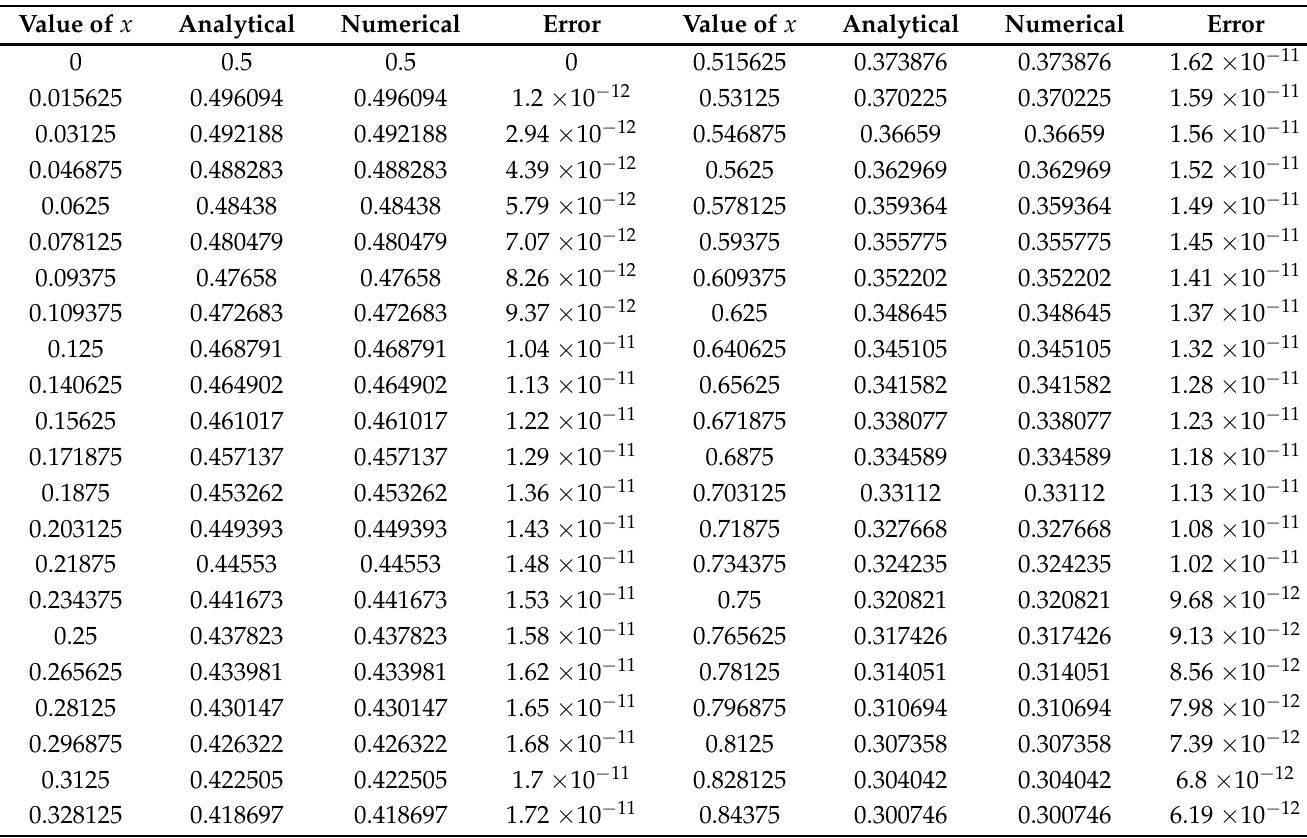
Table 2. Analytical and numerical matching along MKud. and TQBS